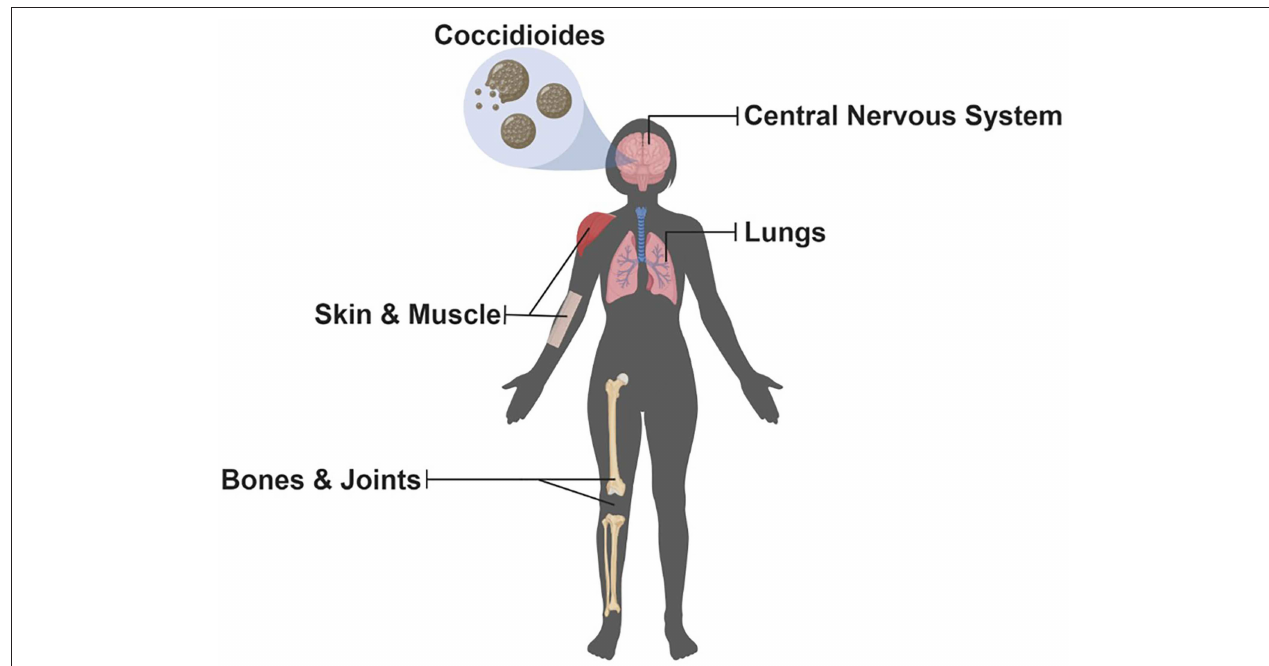
FIGURE 1 | Potential Organs Infected by Coccidioides . Since inhalation is the most common route of infection, the lungs are the most common organ that becomes infected with Coccidioides ; however, dissemination can occur allowing for multiple organs, highlighted above, to become infected but are uncommon (Illustration created with